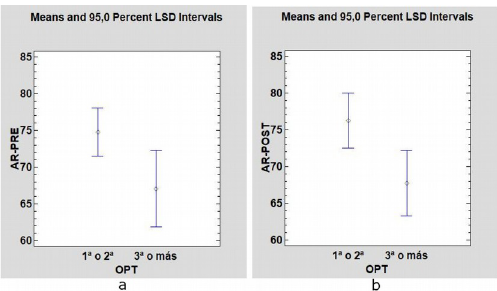
Figure 5. Effect of OPT (Option) factor on pre (a)